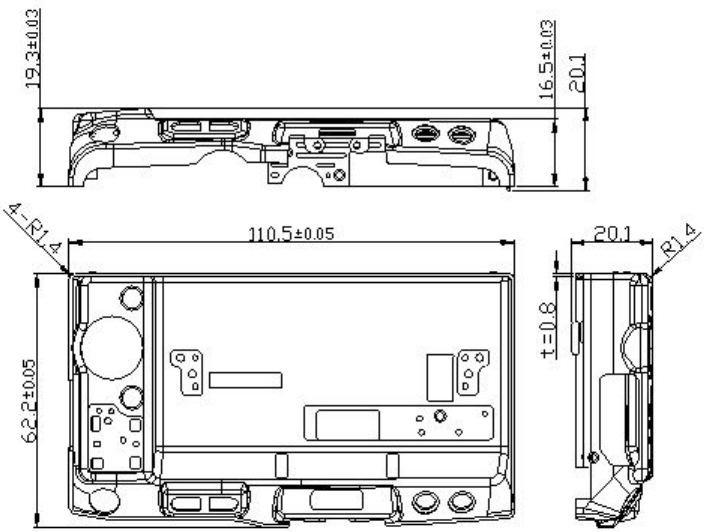
Figure 2. Camera cover model (unit: mm).